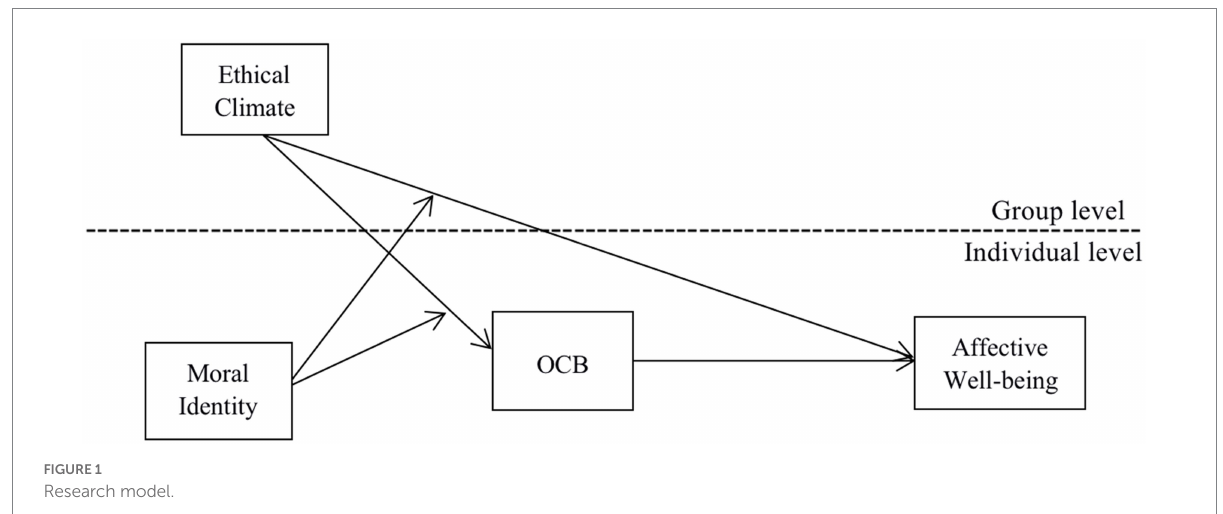
FIGURE 1 Research